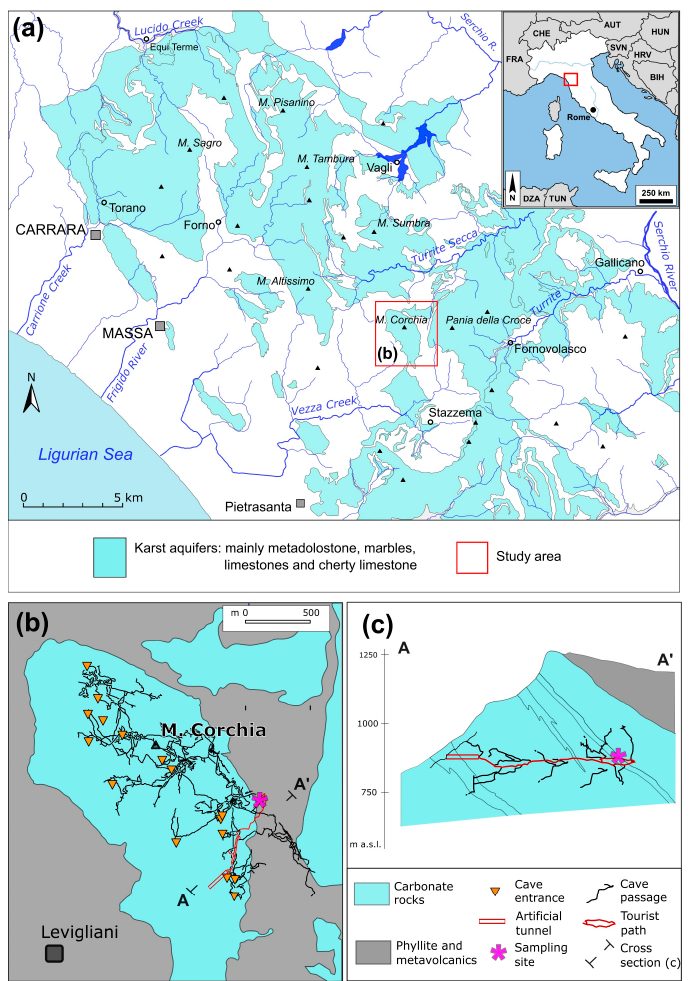
Figure 1. ( a ) Location of Monte Corchia and schematic map of Apuan Alps’ karst area; ( b ) plan view of Corchia Cave karst system; ( c ) projected cross-section through the tourist path of Corchia Cave. Note that the sampling site is about 400 m below the surface and overlayed by low-permeable rocks.